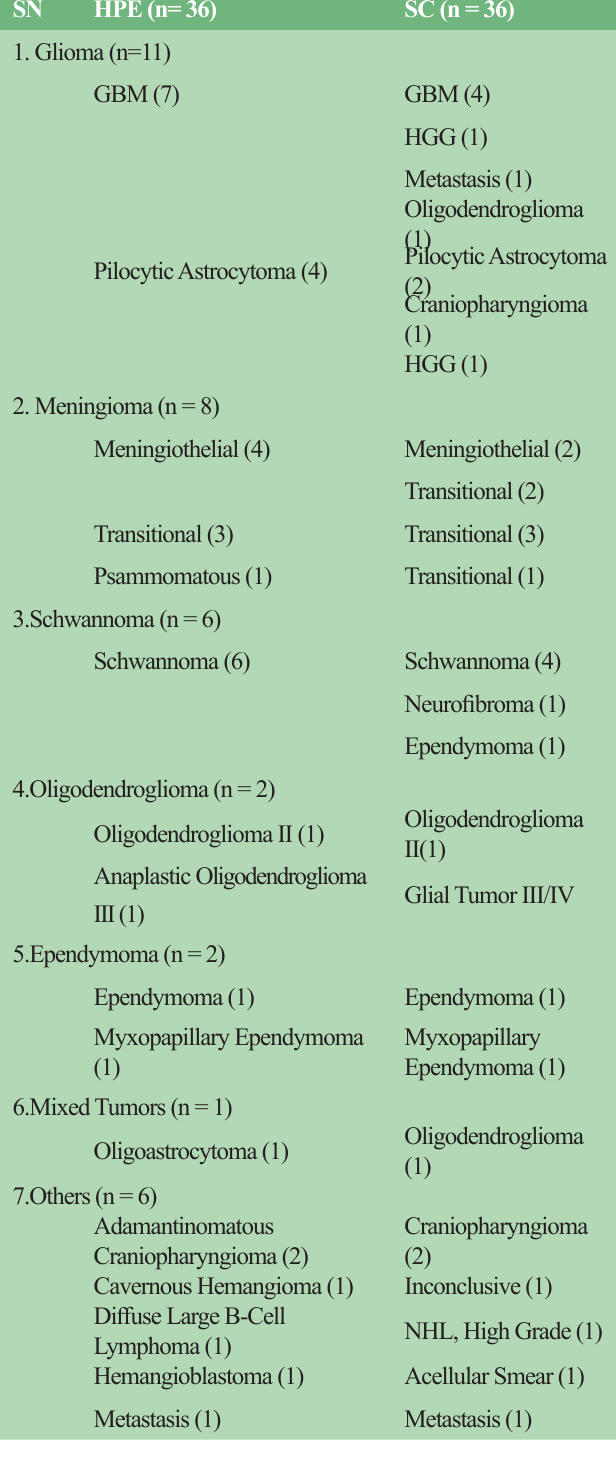
Table1: Comparative reports of histopathological examination and squash